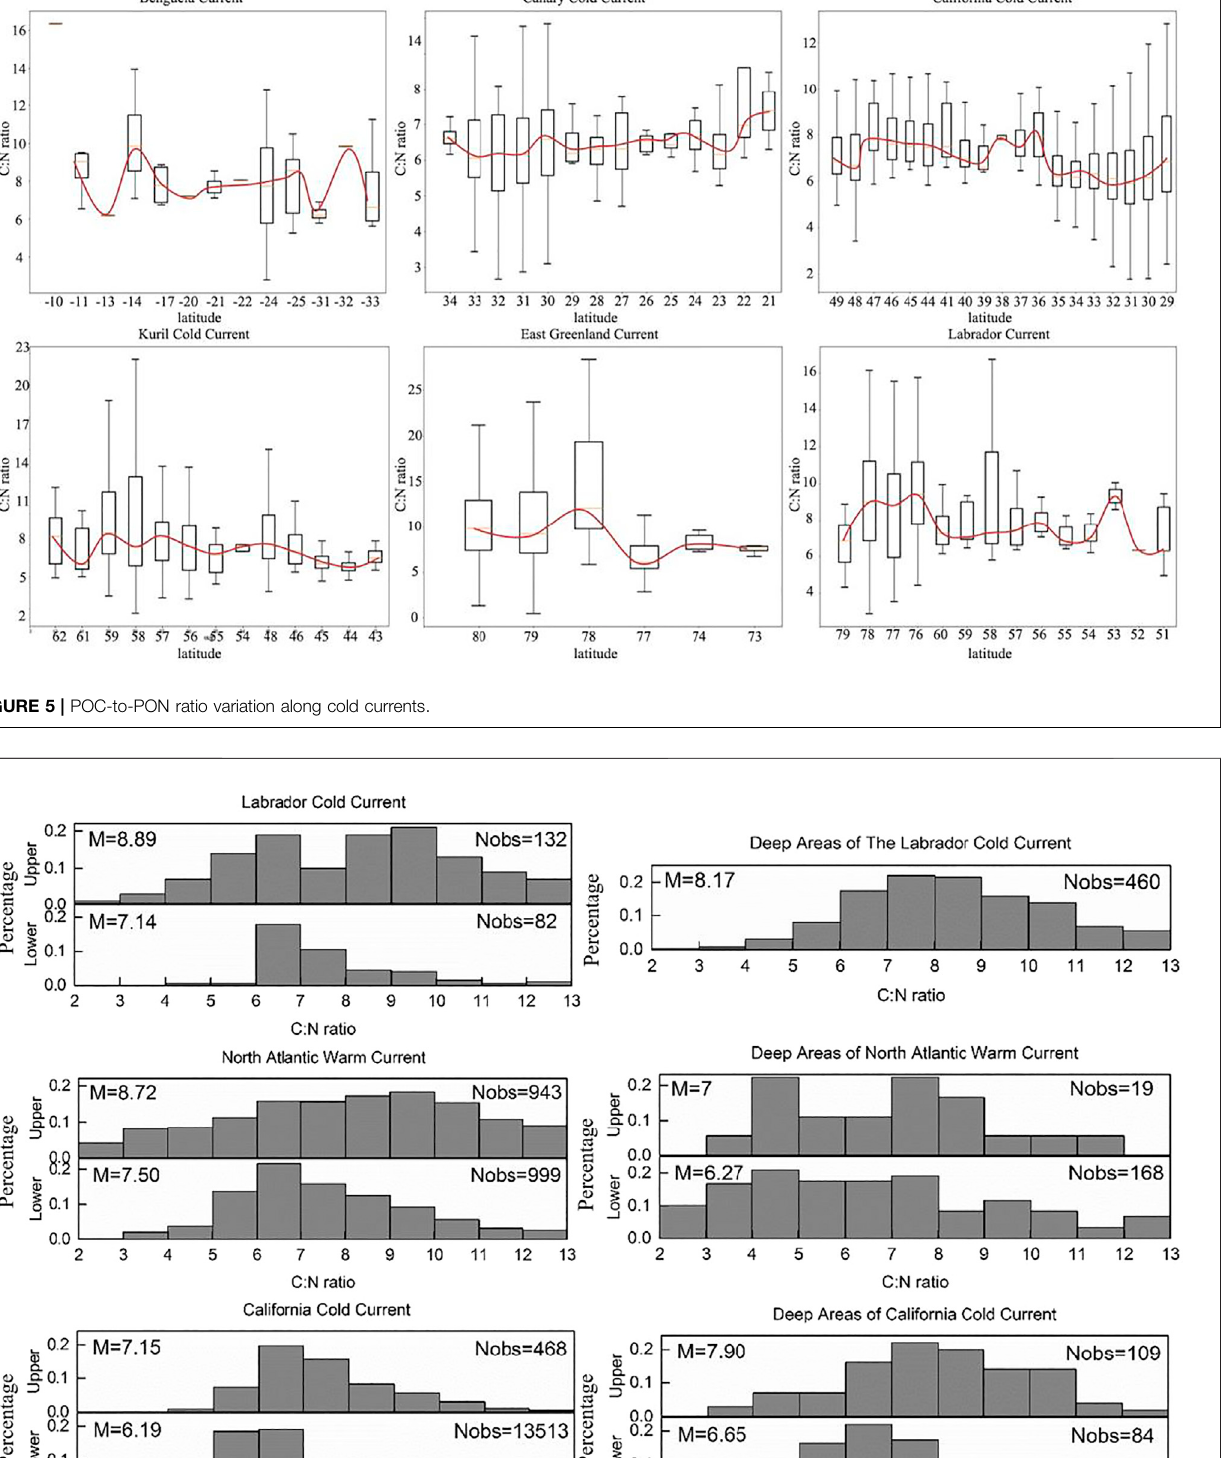
Frontiers in Environmental Science |